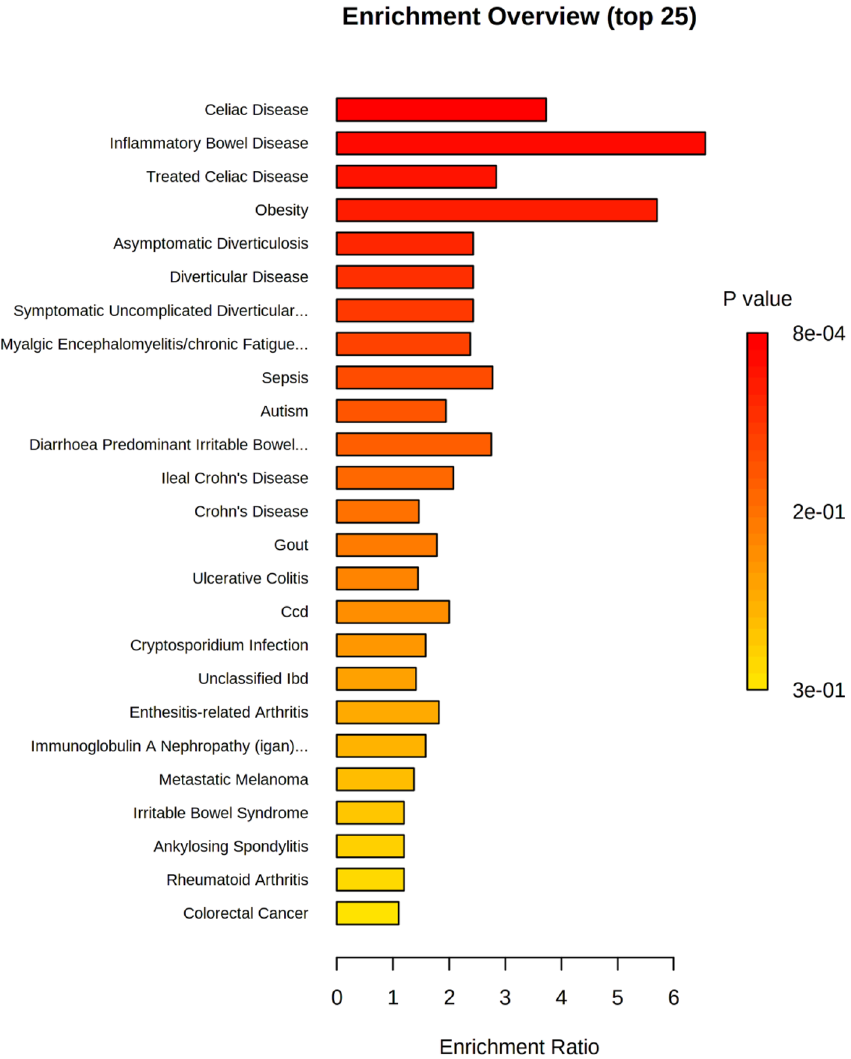
Figure 7. Enrichment analysis of disease signatures performed using 44 metabolite sets reported in human feces. Significant metabolite sets ( p ): celiac disease (< 0.001), inflammatory bowel disease (0.001), treated celiac disease (0.008), obesity (0.016), asymptomatic diverticulitis (0.031), diverticular disease (0.031), symptomatic uncomplicated diverticular disease (0.031), and chronic fatigue syndrome